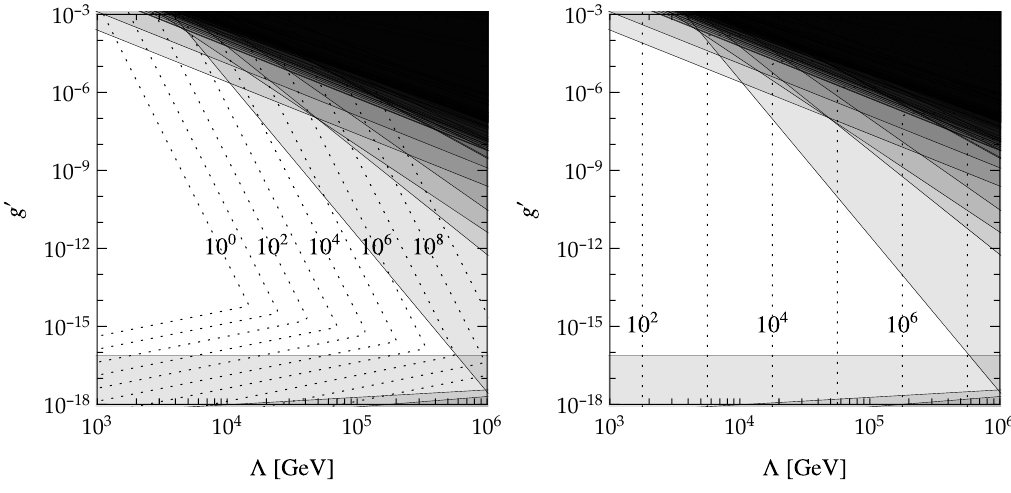
Figure 24 . Same region as in (cid:12)gure 17 (fragmentation during in(cid:13)ation) where we show the contours of the minimum (left) and maximum (right) values of the number of e-folds N e required for a successful relaxation.